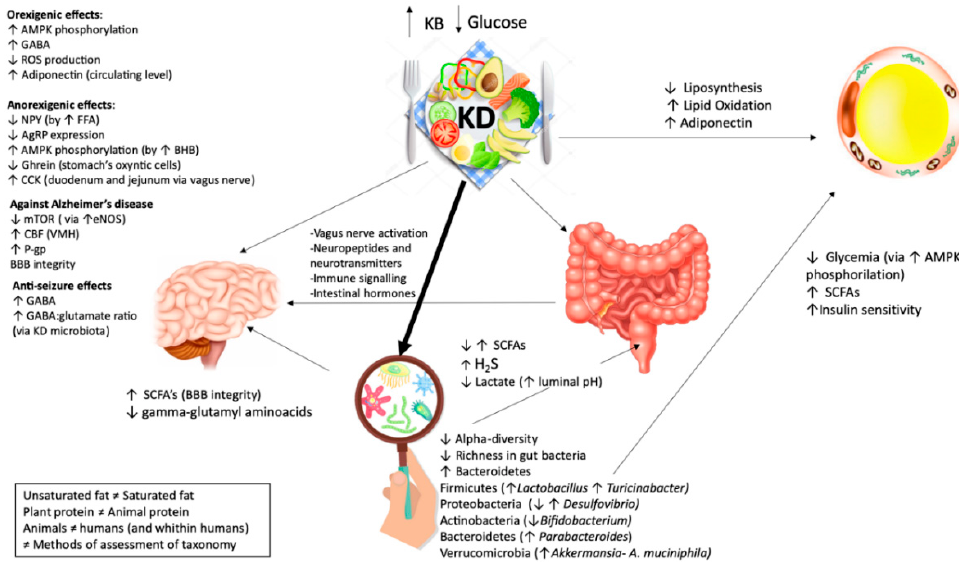
Figure 2. Effects of ketogenic diet on different tissues and the microbiome. Figure 2. E ff ects of ketogenic diet on di ff erent tissues and the microbiome. KD has a